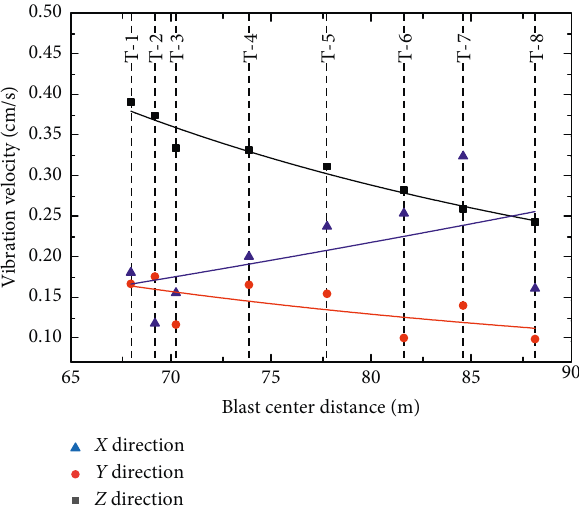
Figure 7: Relationship between the vibration velocity and the blast center distance of the lower step.